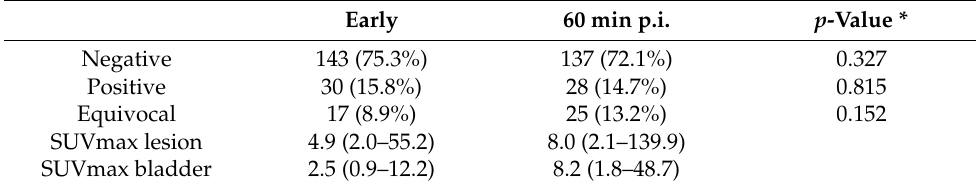
Table 2. Comparison of the early vs. 60 min p.i.